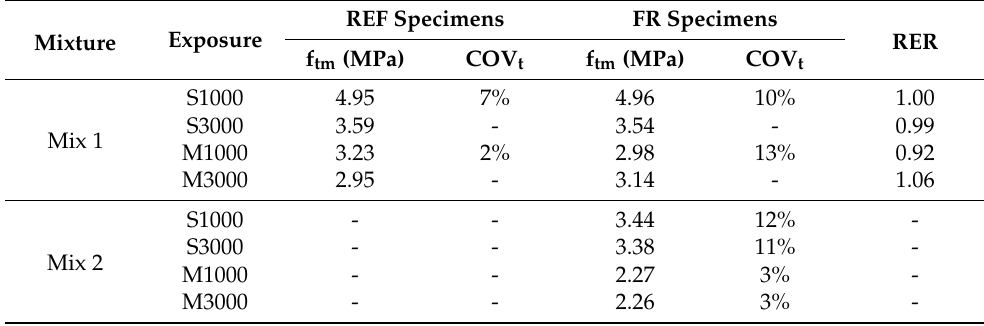
Table 6. Results of flexural strength of C specimens subjected to saline and moisture conditioning.